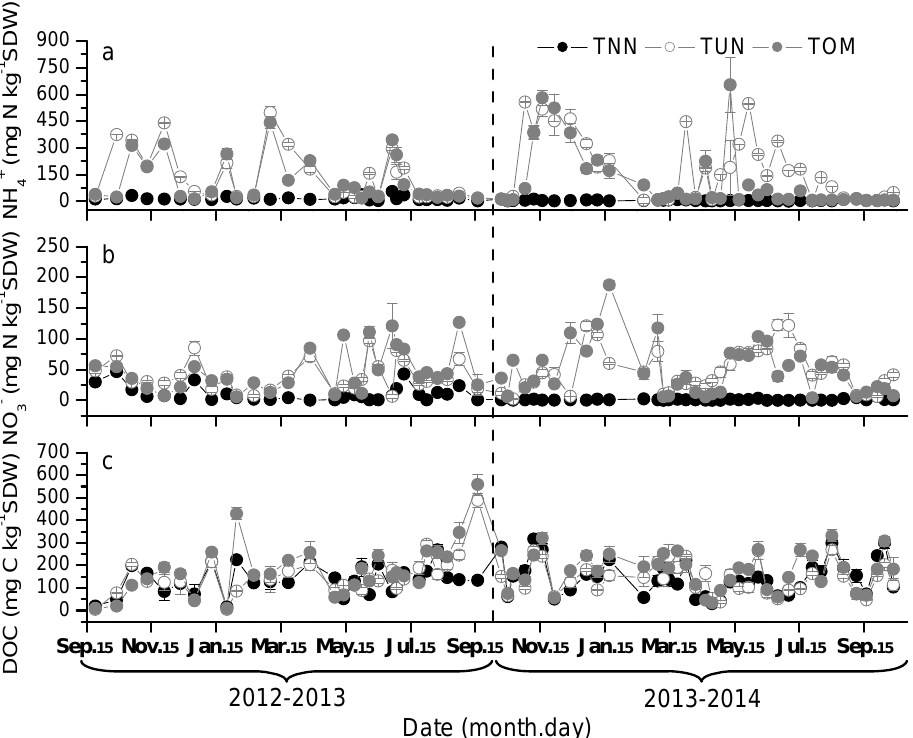
) , (b) nitrate (NO − ) , and (c) dissolved organic carbon (DOC) concentrations Figure 2. Seasonal changes of the soil (a) ammonium (NH + 4 3 (mean ± standard error) for all the fertilizer treatments ((i.e., the common practice with urea application (TUN), the alternative practice with organic fertilizer application (TOM), and no nitrogen fertilizer application (TNN)) in tea plantations during the period from September 2012 to October 2014. SDW is the abbreviation of soil dry